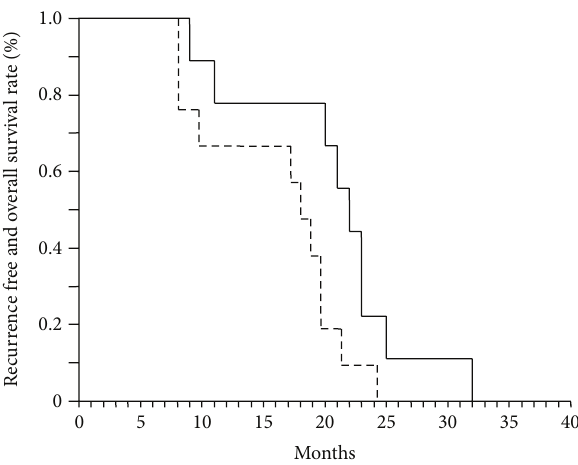
Figure 1: Kaplan Meier curve of recurrence free (dotted line) and overall (solid line) survival (median 21 and 22 months, resp.).